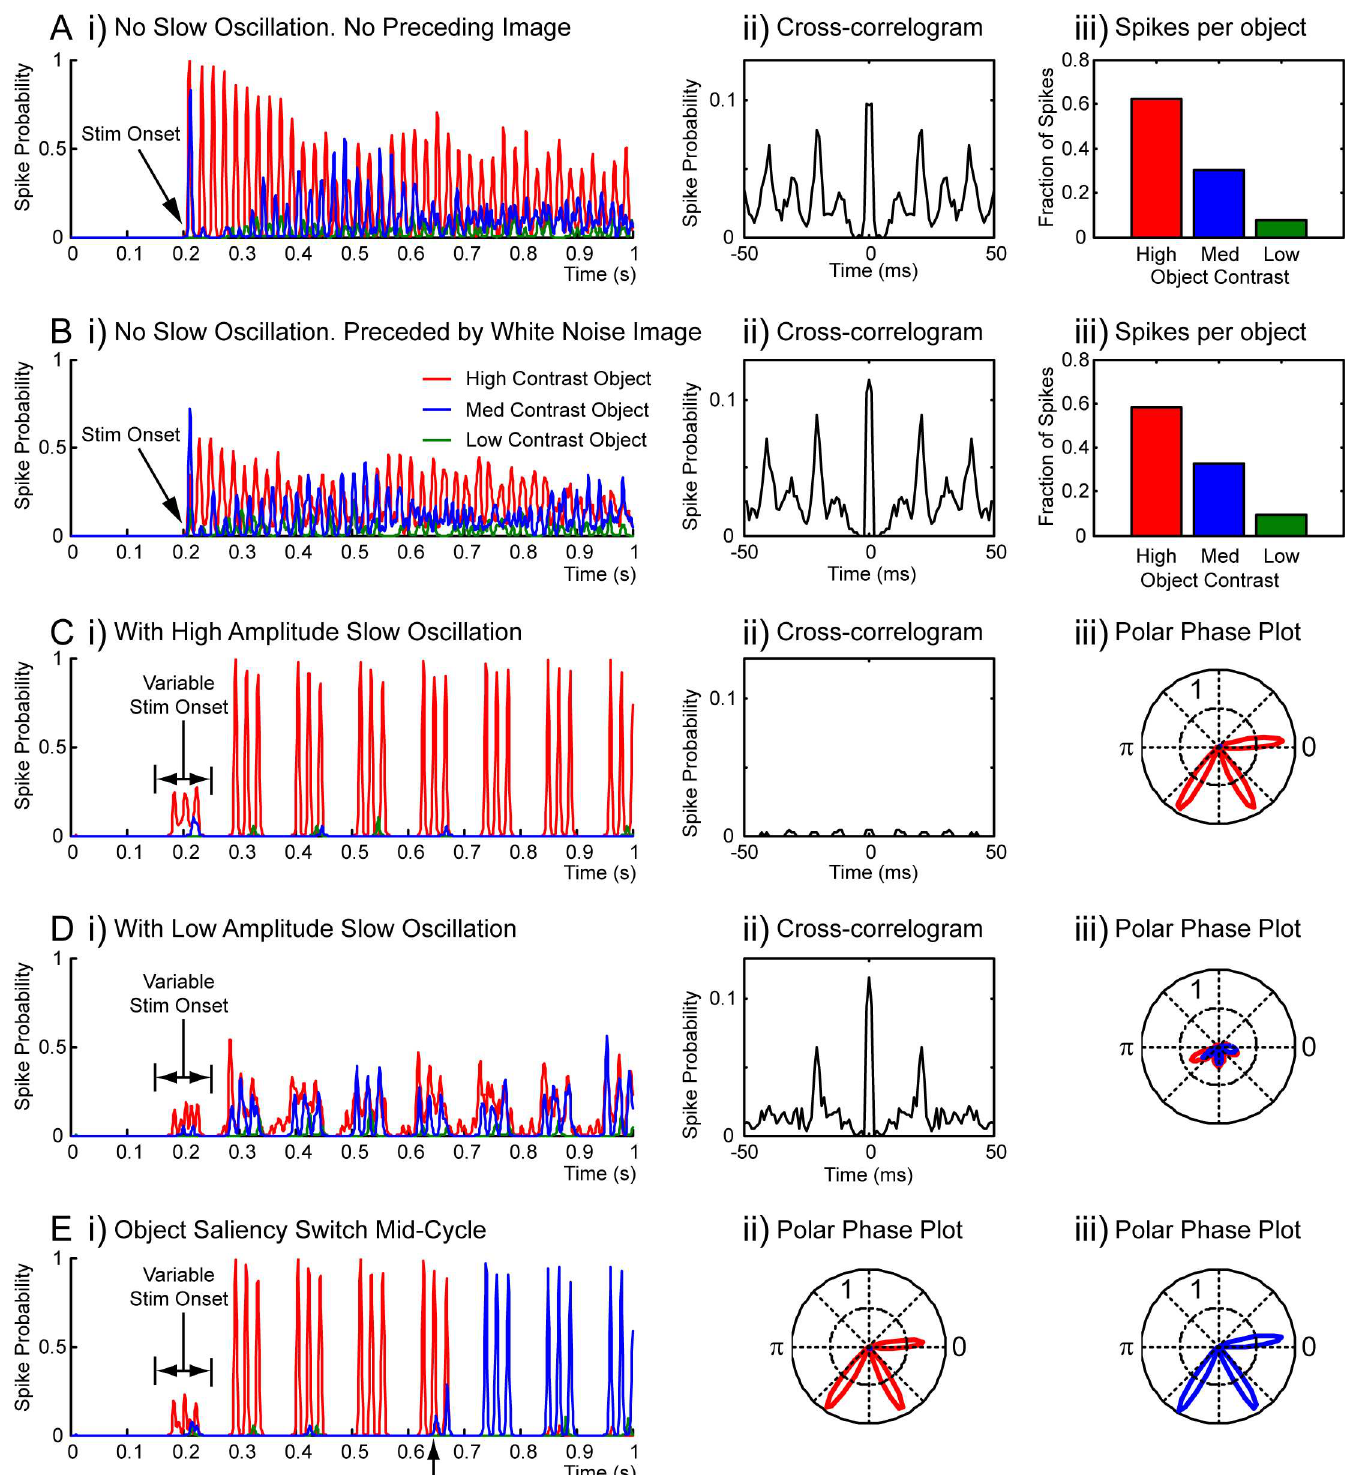
Fig 5. F-multiplexing–the slow oscillation. Results from several series of simulations (100 repeats each), summarizing activity in the higher area (red for high contrast object, blue for mid, green for low). A. Without the slow oscillationto rhythmically reset the system, selection via the CTC mechanism fails over time, as the independent gamma oscillations in the lower area shift in and out of synchrony (because of their slightly different frequencies).